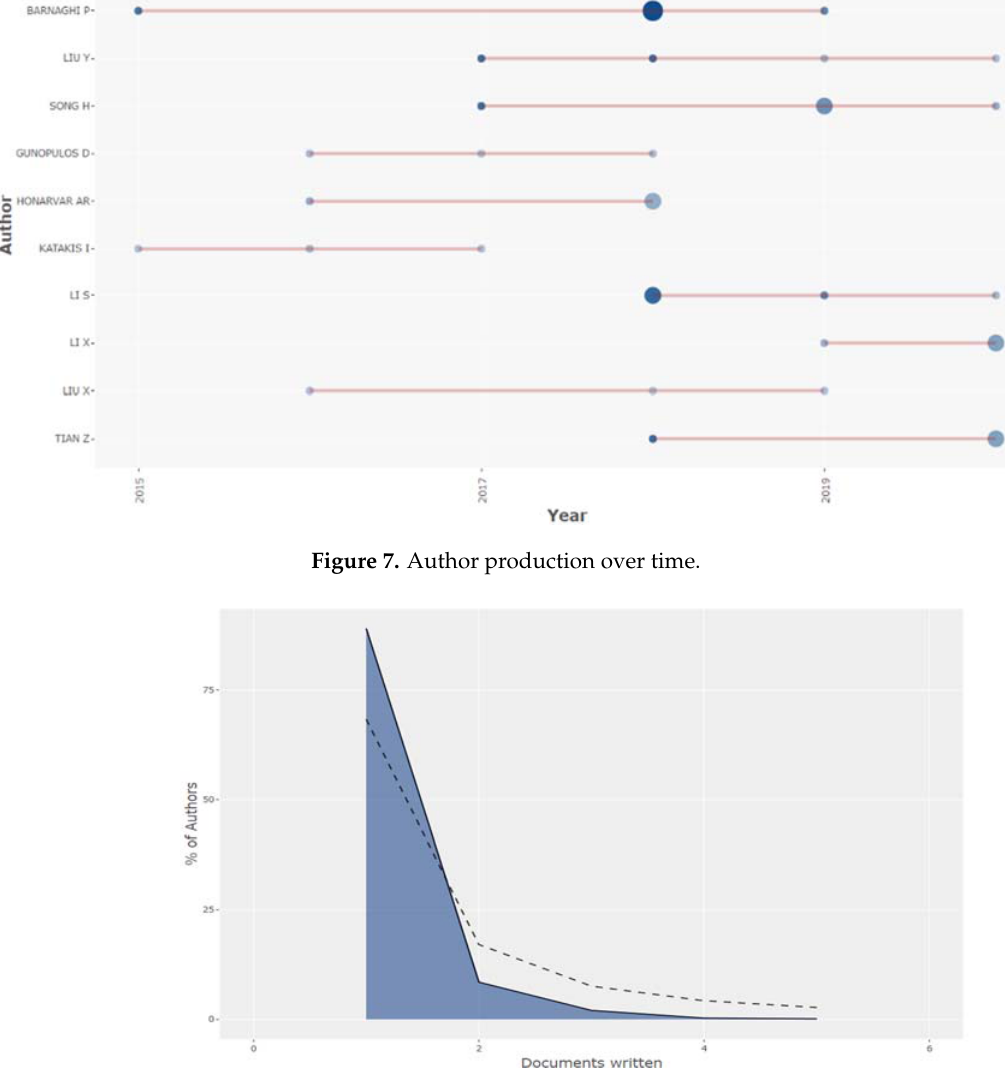
Figure 7. Author production over time.